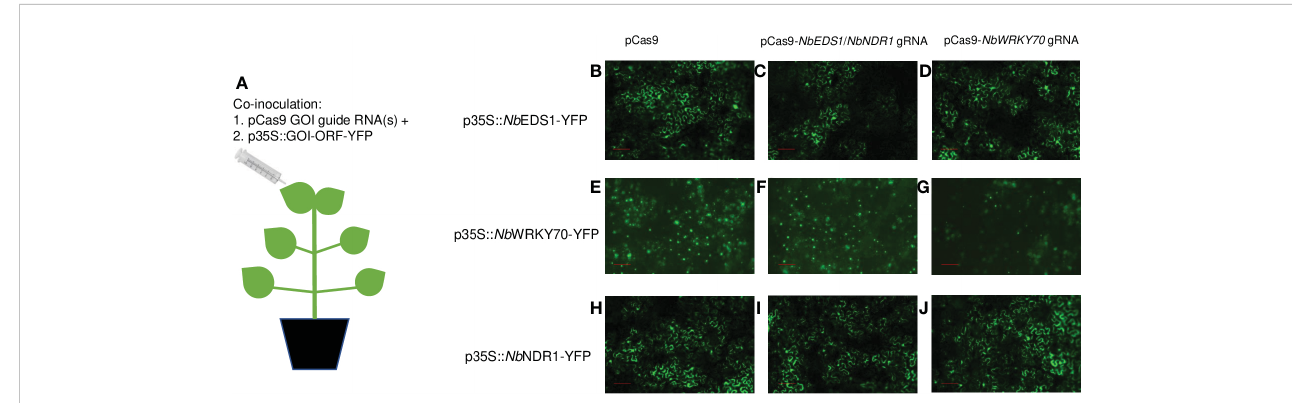
FIGURE 1 Evaluate the effectiveness of gRNAs targeting NbEDS1 , NbNDR1 , NbWRKY70 via Agrobacterium -mediated transient assay. (A) The co-inoculation scheme of A. tumefaciens strains carrying p Cas9 - GOI gRNA and p35S:: GOI-YFP on N. benthamiana . p35S:: NbEDS1-YFP (B – D) , p35S:: NbWRKY70-YFP (E – G) , and p35S:: NbNDR1-YFP (H – J) were respectively co-inoculated with pCas9 empty vector (no gRNA), p Cas9 - NbEDS1/NbNDR1 gRNAs, and p Cas9 - NbWRKY70 gRNA. The YFP signals were detected by a fl uorescent microscope at 48 hour post inoculation. NbEDS1 gRNA and NbWRKY70 gRNA, but not NbNDR1 gRNA, can trigger gene editing when co-expressing with pCas9-GOI gRNA in Agrobacterium -mediated transient assays in N. benthamiana , which resulted in reduced fl uorescent signals. Scale bar represents 100 µm. GOI; gene of interest, YFP; yellow fl uorescent protein, 35S; Cauli fl ower mosaic virus 35S